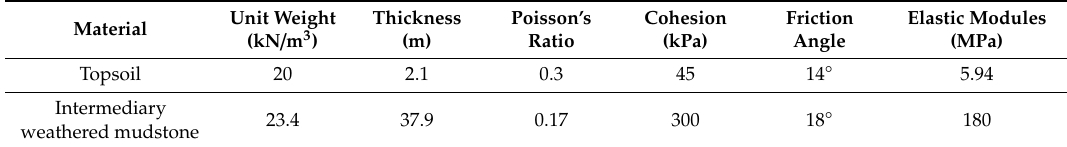
Table 1. Physical parameters of soil.